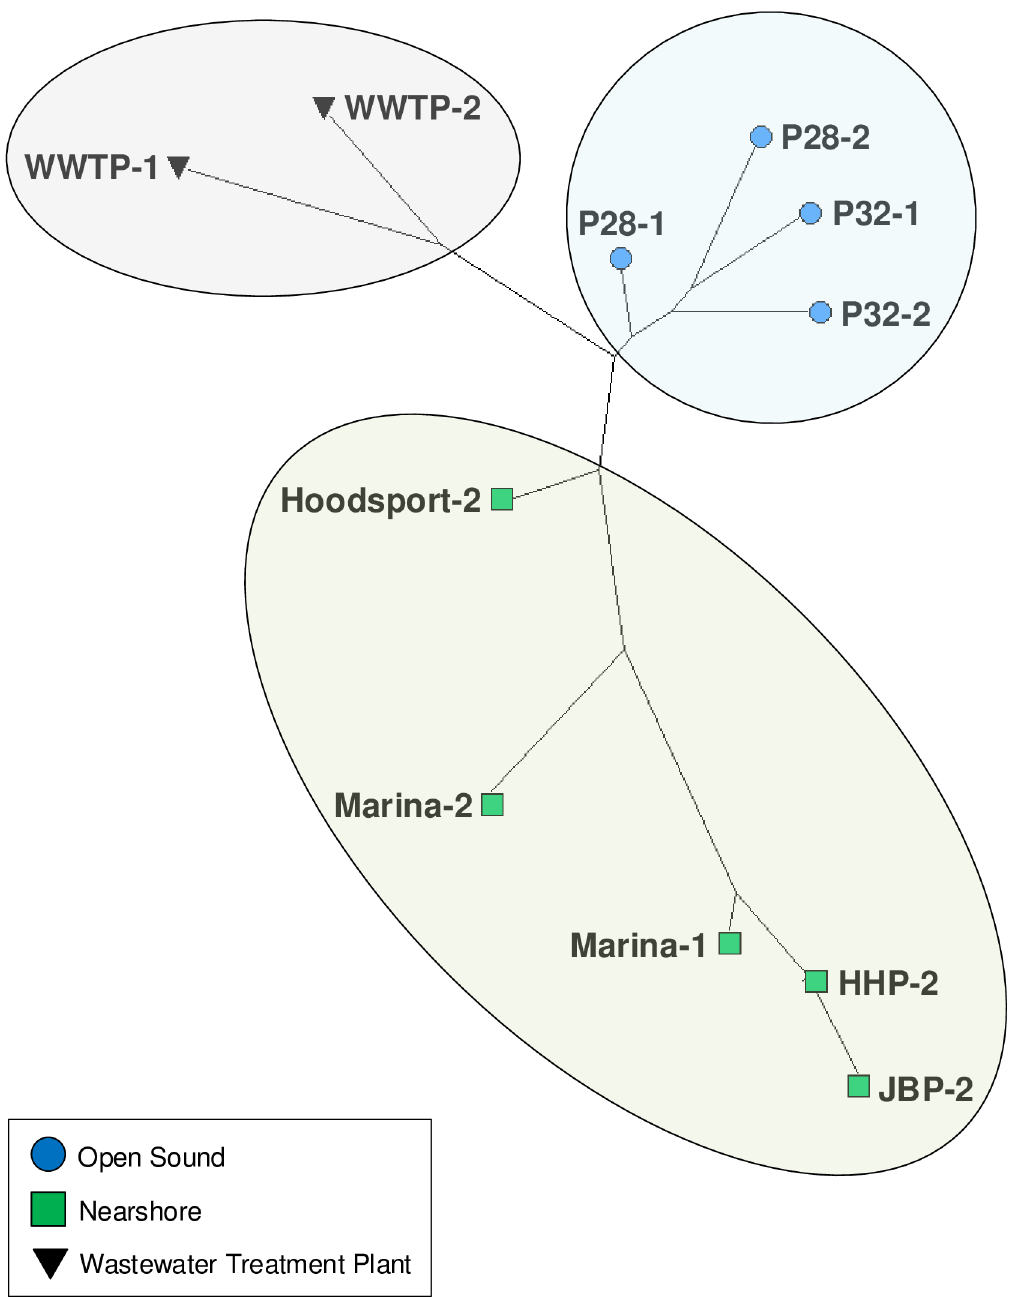
Fig 6. Neighbor-joining tree representation of phylogenetic distances for sewage associated bacterial families. Open sound samples were taxonomically closer in relative abundance to WWTP samples than Marina and Herring’s House Park samples although smaller in absolute abundance as shown in Fig